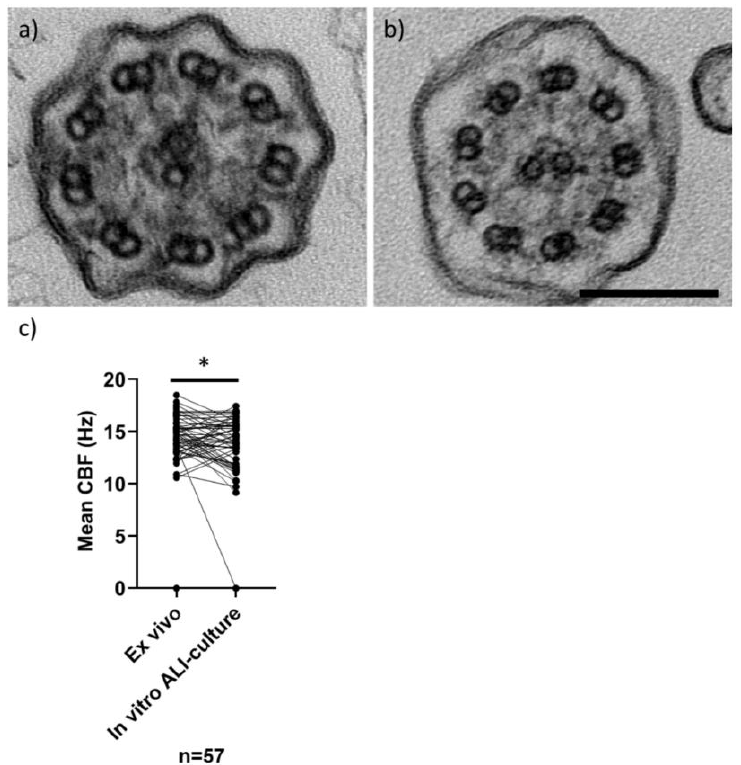
Figure 3. TEM of cilia in transverse section and CBF (by HSVA) in nasal samples and after ALI culture. Representative TEM images ( a , b ) of in vitro ALI-cultured cilia in transverse section, showing a “9 + 2” microtubular arrangement. Cilia have normal ciliary ultrastructure in ( a ) a “PCD highly-unlikely” subject (with 3% microtubular defects, 18% inner and 4% outer dynein arm defects quantified from 102 cilia), and ( b ) a “PCD positive” subject (with 11% microtubular defects, 47% inner and 99% outer dynein arm absence quantified from 302 cilia). Scale bar represents 100 nm. Dot plot ( c ) demonstrates the mean CBFs (Hz) of 57 ex vivo nasal brushing samples compared to their matched in vitro ALI cultures (Wilcoxon paired test * p = 0.03). Data from ex vivo samples without a matched ALI sample were excluded ( n = 13), which was due to 7 ex vivo samples with a variable ciliary beat pattern (CBP), 3 with failed ALI cultures and 3 that were not cultured. Normal CBF range of ex vivo samples